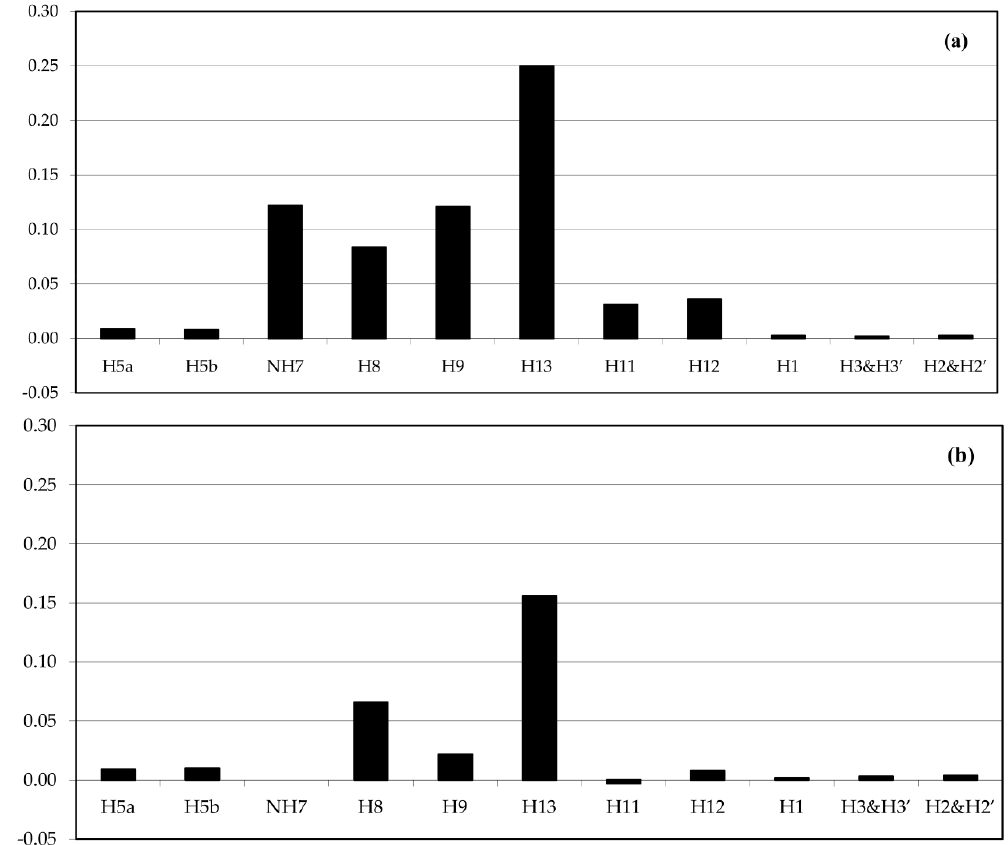
Figure 6. The Δδ for the PenNa and the PenAg in DMSO-d 6 ( a ) and in MeOD-d 4 ( b ). Figure 6. The ∆ δ for the PenNa and the PenAg in DMSO-d 6 ( a ) and in MeOD-d 4 ( b